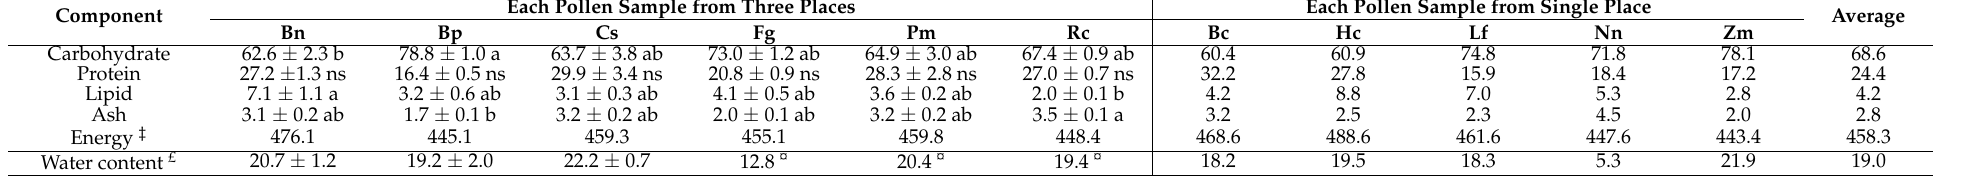
Table 2. Proximate composition and energy value of bee pollen samples (g/100 g dry mass) † .